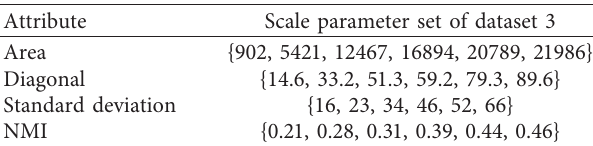
Table 3: Extracted scale parameter set of dataset 3. Attribute Scale parameter set of dataset